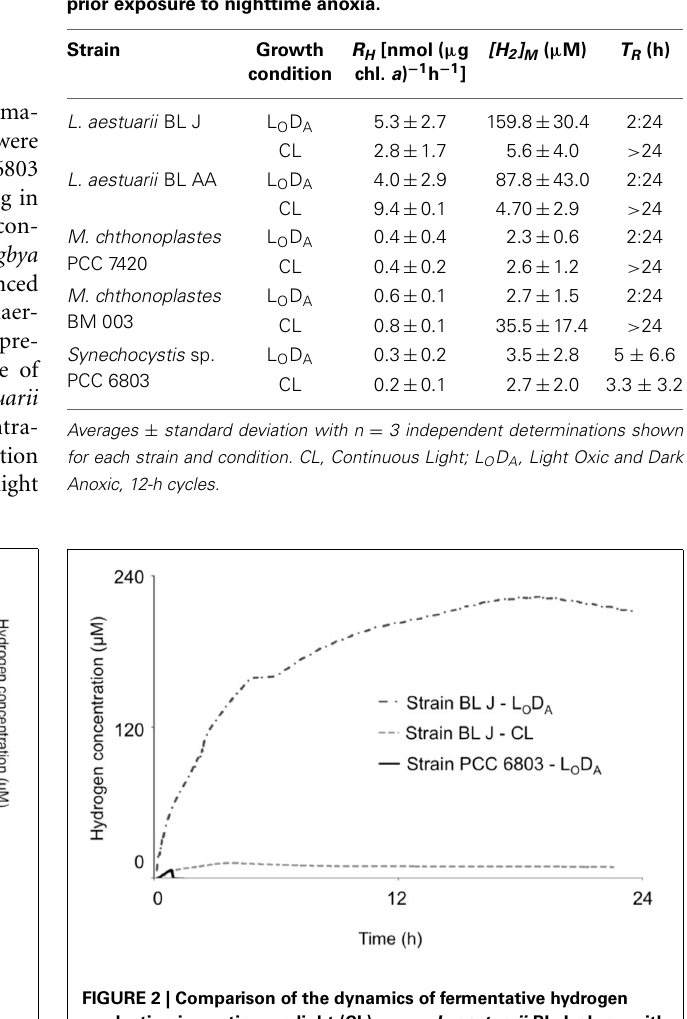
Table 1 | Parameters characterizing the dynamics of fermentative H 2 production in various cyanobacterial strains along with the effect of prior exposure to nighttime anoxia.